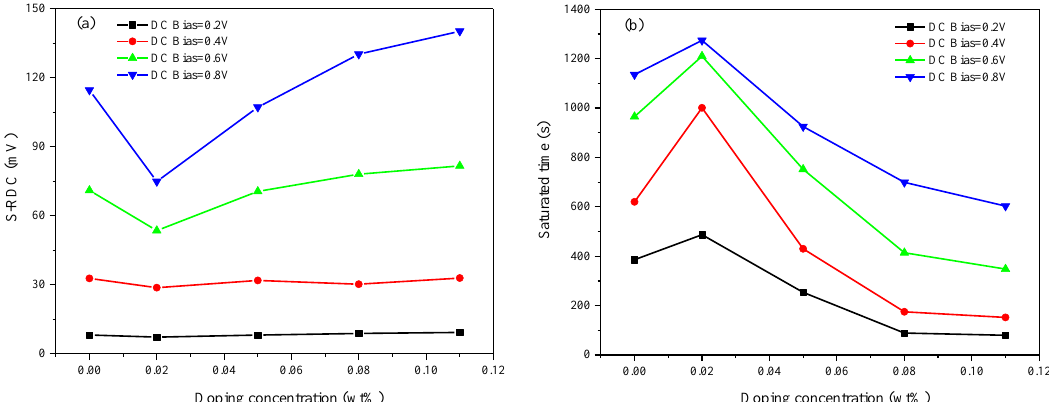
Figure 7. ( a ) Saturated residual DC voltage of different concentrations at different DC bias voltages. ( b ) Saturated time of different concentrations at different DC bias voltages.